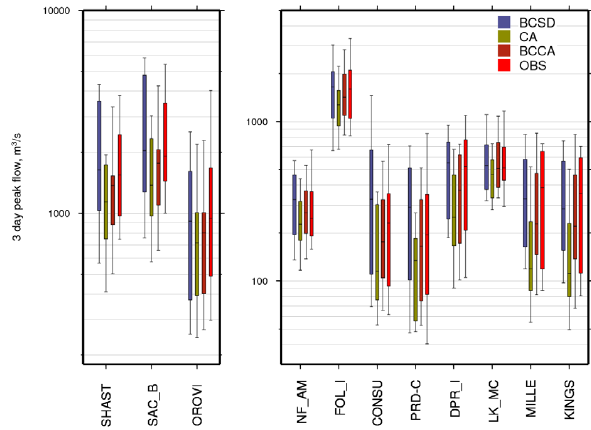
Figure 7. 3-day peak flow for each streamflow site. Note the vertical axes are different for 2 each of the panels. 3